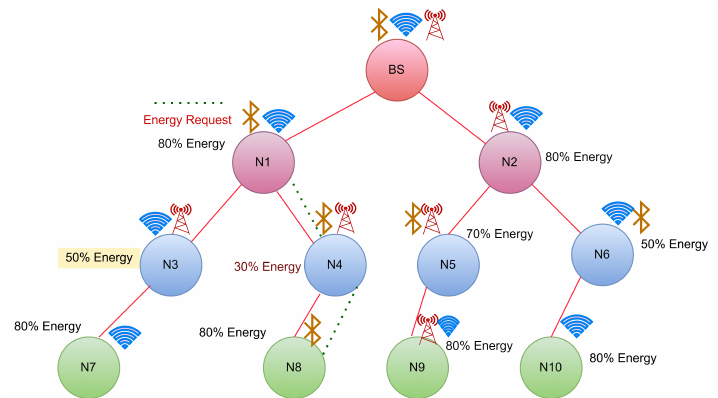
Figure 7. Case 3:Energy request from N4 to its neighbour hops.